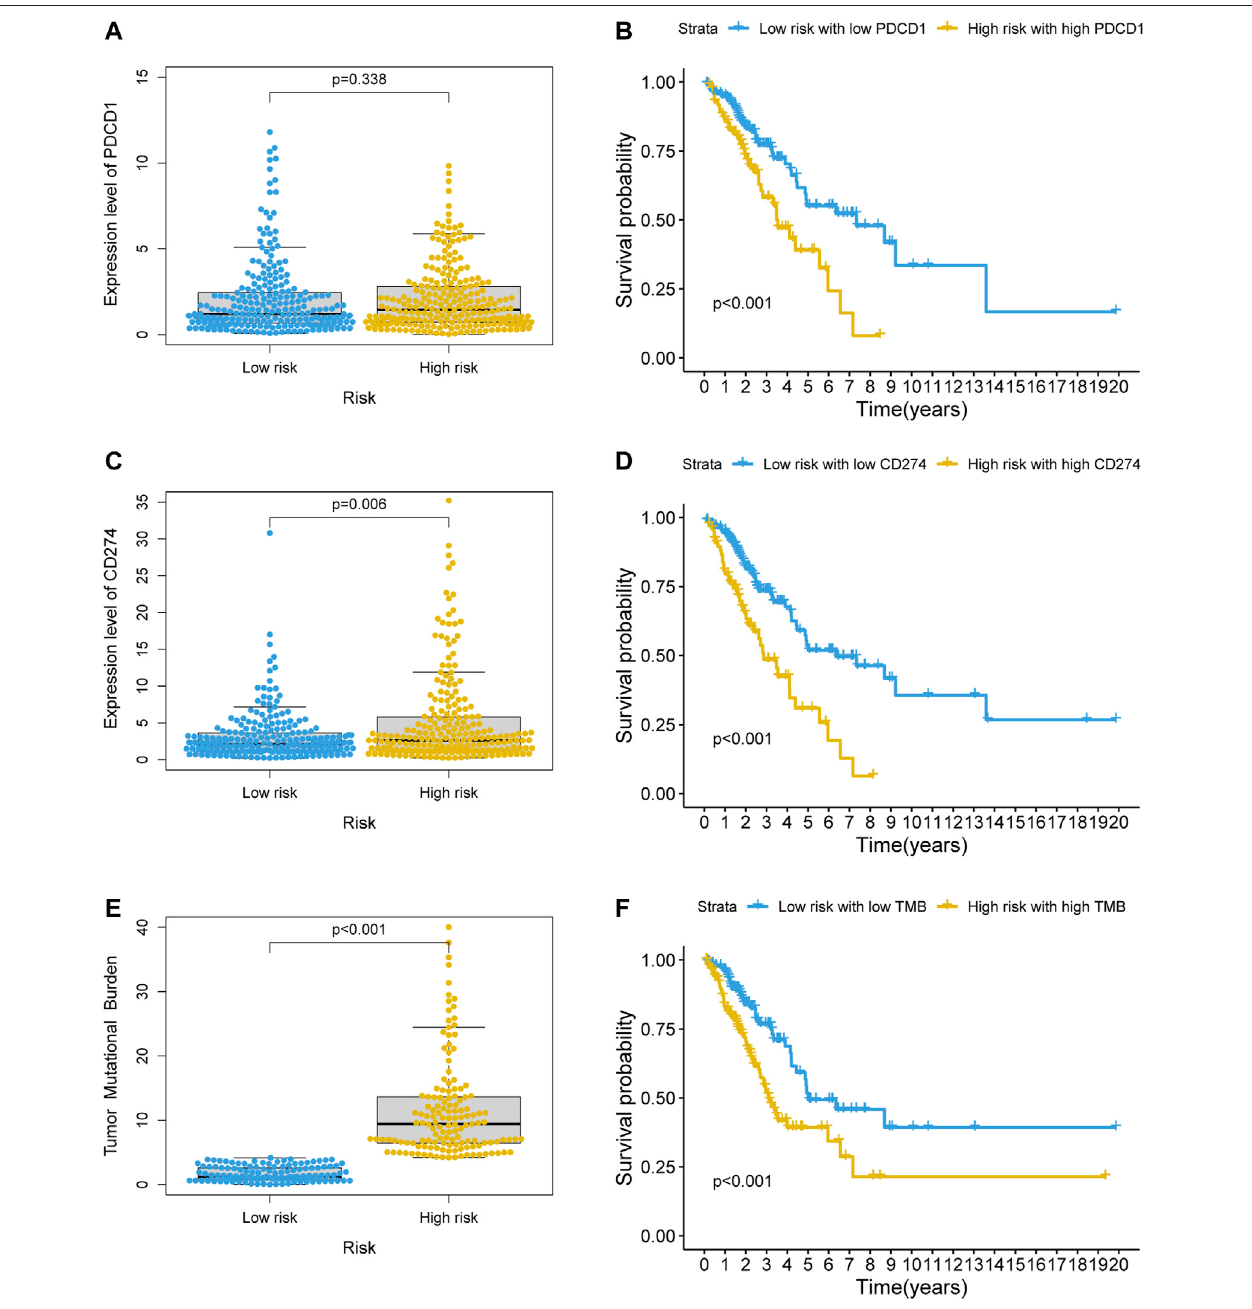
FIGURE8| Value ofthe GI-lncRNA model forpredicting theresponsetoimmunotherapy.Comparison ofexpression levels of (A) PDCD1, (C) CD274between the low-risk and high-risk groups strati fi ed by the risk scores of the GI-lncRNA-based model; Kaplan – Meier curve analysis of OS in (B) the low-risk group with low PDCD1 versus high-risk group with high PDCD1, and (D) low-risk group with low CD274 versus high-risk group with high CD274; (E) Comparison of difference in tumor mutational burden (TMB) between the high- and low-risk groups; (F) Kaplan – Meier analysis of OS in the low-risk group with low TMB versus high-risk group with high